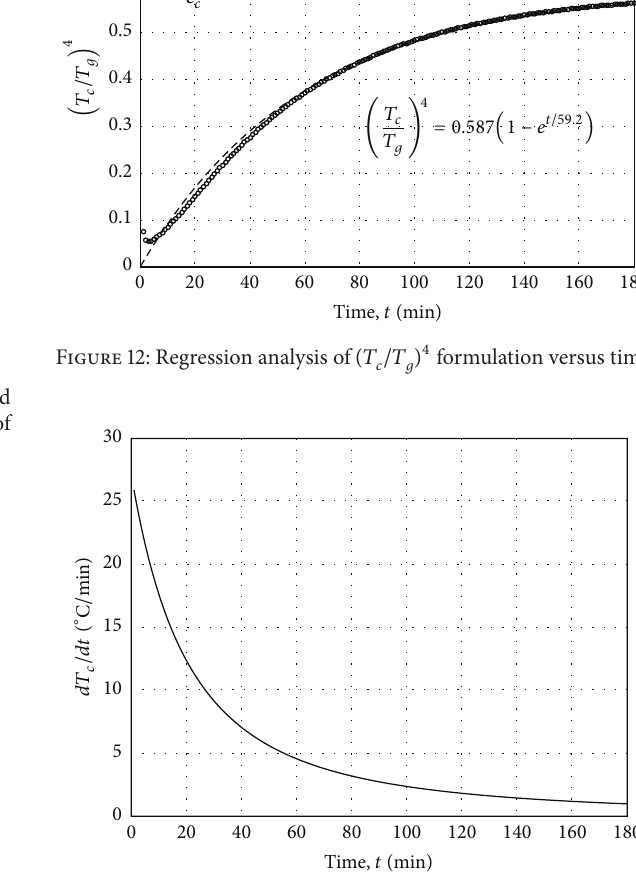
Figure 13: Time rate of temperature increase 𝑑𝑇(𝑡,0)/𝑑𝑡 versus